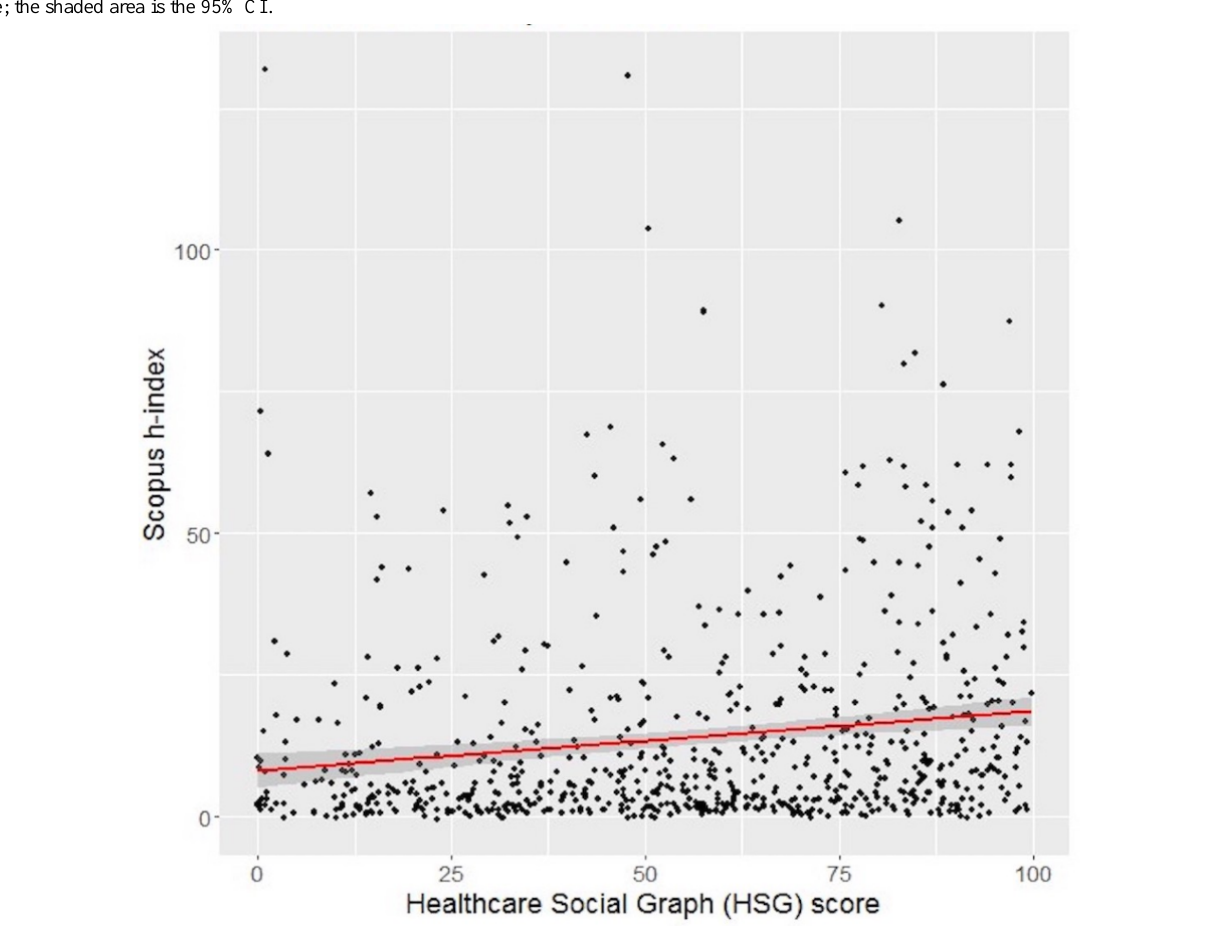
Figure 3. Correlation between HSG scores and Scopus h-indexes. Spearman correlation coefficient ρ =0.2173 (N=715). The red line is the regression line; the shaded area is the 95%